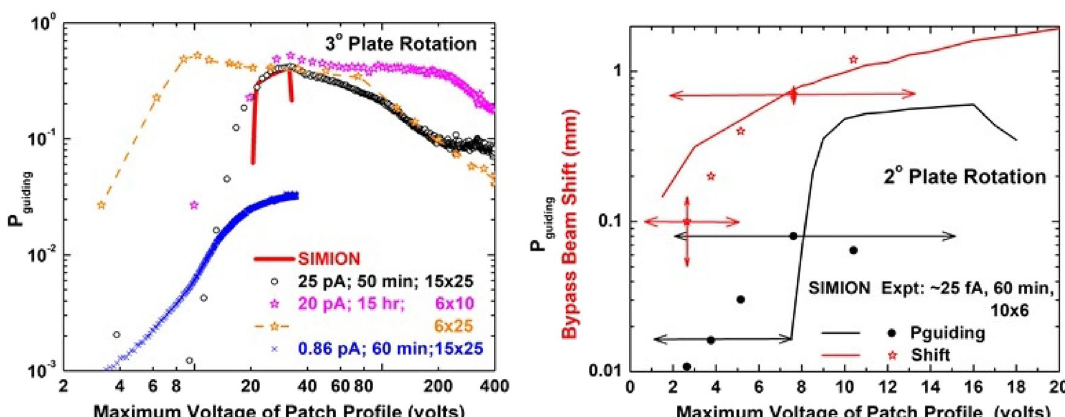
Figure 8. Guiding probabilities and bypass beam deflections as a function of the maximum voltage of the charge patch profile. Left figure is for a 3° plate rotation with the solid red line showing the SIMION predictions and the symbols showing the experimental data. The beam current, discharge time prior to data collection, and the estimated effective dimensions of the charge patch are listed for each dataset. The right figure is for a 2° rotation with guiding probabilities shown in black and beam shifts shown in red. The horizontal arrows indicating how each curve would shift for effective charge patch areas ranging from the minimum to maximum values of the effective capacitor plate area. The vertical arrows show estimated uncertainties in extracting shift